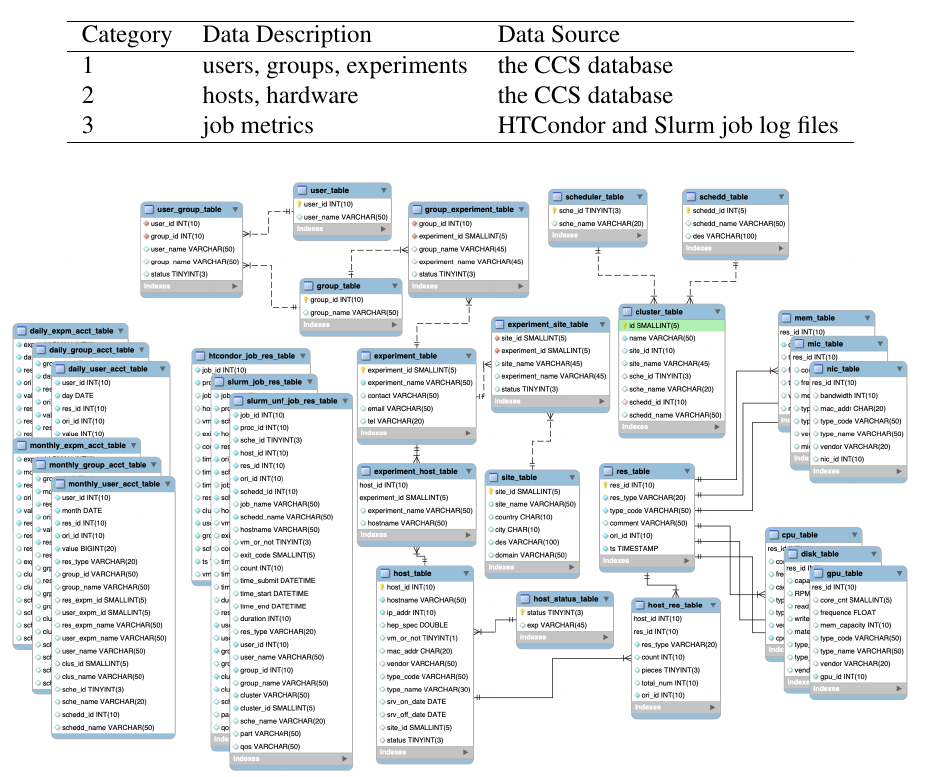
Figure 2: The schema design of the cosmos_db